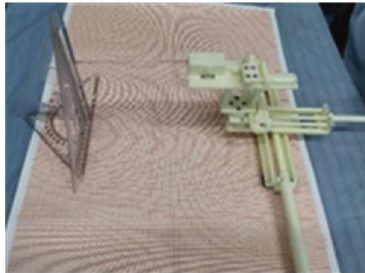
Figure 21: The position of each vertex in the coordinate board.